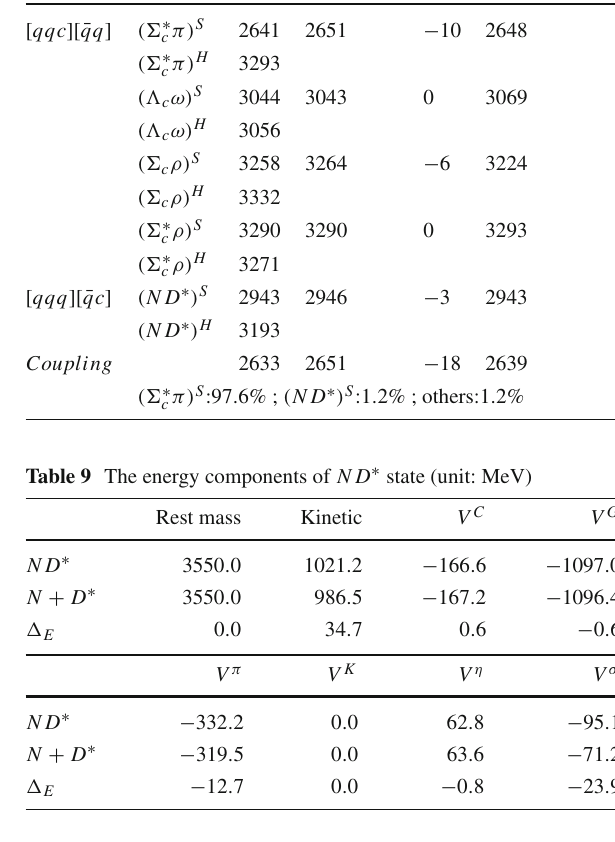
Table 10 The RMS distances of qqq ¯ qc pentaquark system with quan-